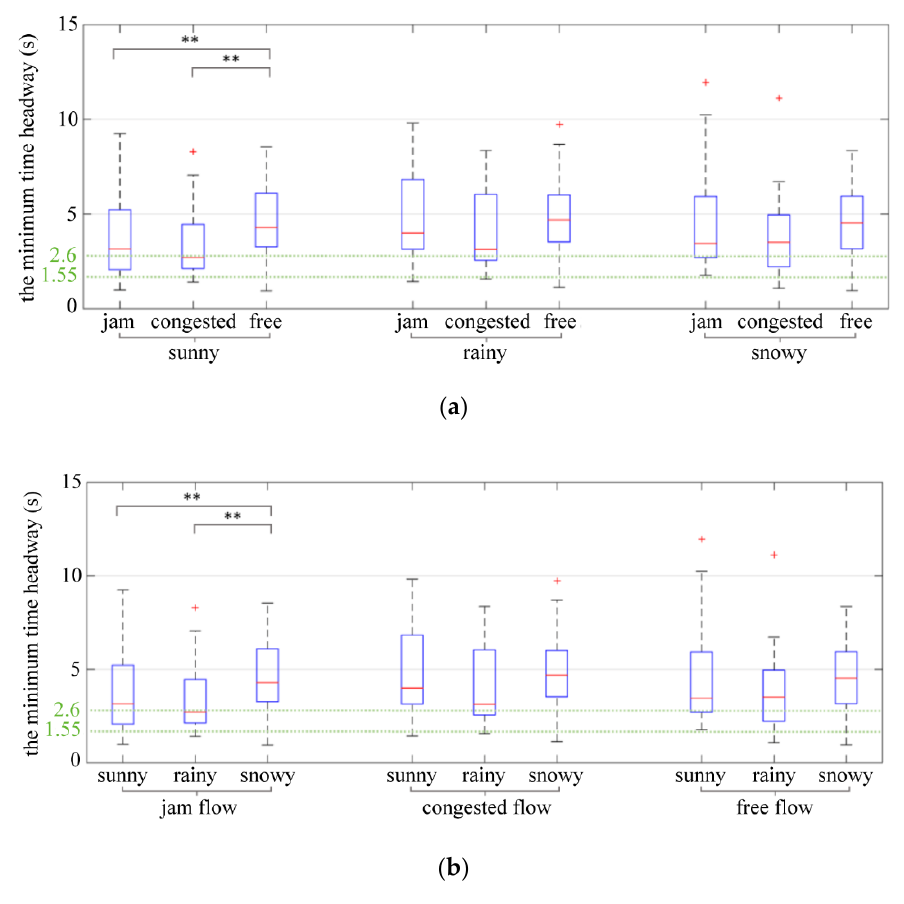
Figure 10. The minimum time headway. ( a ) The minimum time headway in different traffic flow conditions. ( b ) The minimum time headway in different weather conditions. ** indicates the variable was statistically significant at 0.05 level. + indicates outlier.